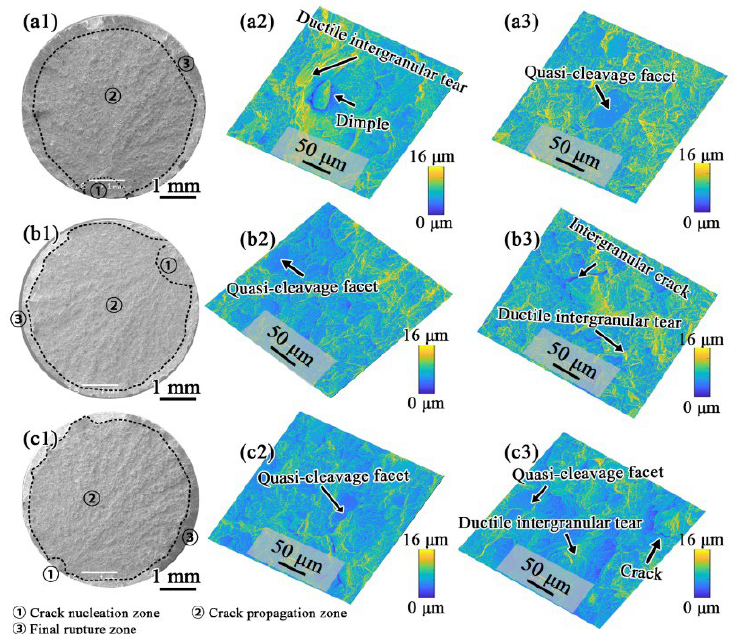
Figure 9. Fractographies of room temperature tensile specimens of ( a1 ) HT-1, ( b1 ) HT-2 and ( c1 ) HT-3, and height contour coloring maps in middle column of ( a2 ), ( b2 ), ( c2 ) correspond to crack nucleation zones, and these in right column of ( a3 ), ( b3 ), ( c3 ) correspond to propagation zones.